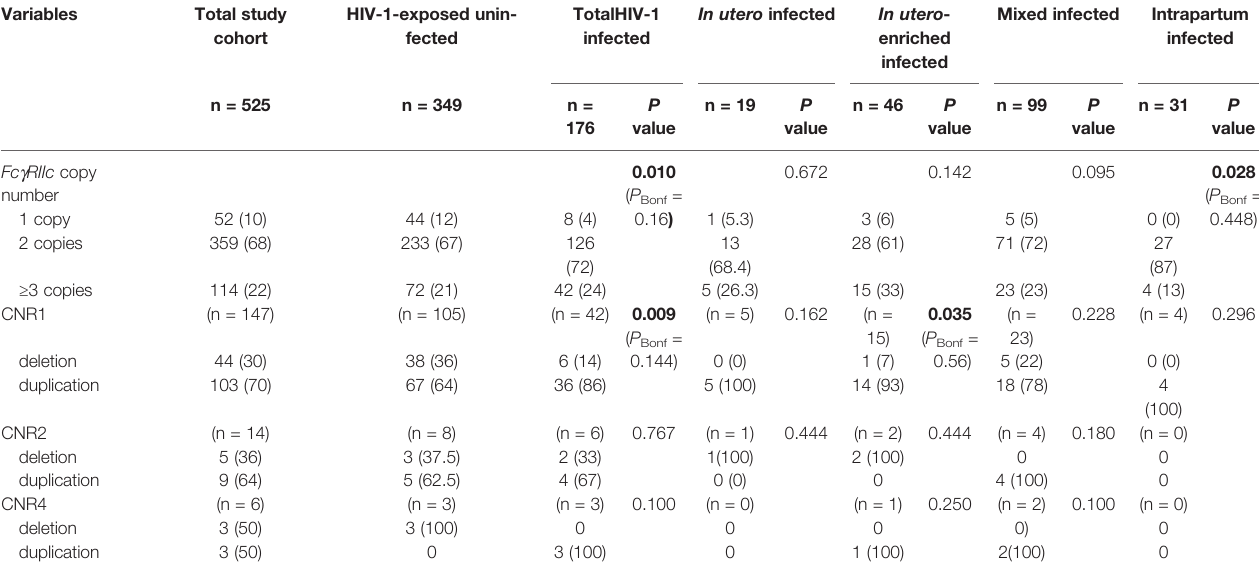
TABLE 2 | FCGR2C copy number distribution in HIV-1-exposed infected and uninfected infants.